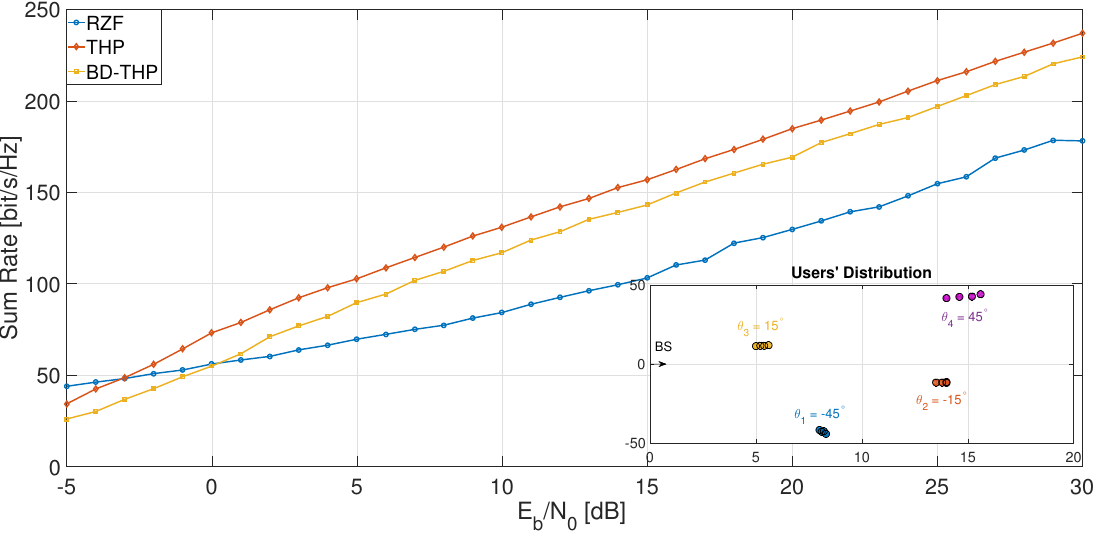
Figure 9. Sum rate vs. E b / N 0 for θ min,g = 1 ◦ and θ g = [ − 45 ◦ , − 15 ◦ ,15 ◦ ,45 ◦ ] .